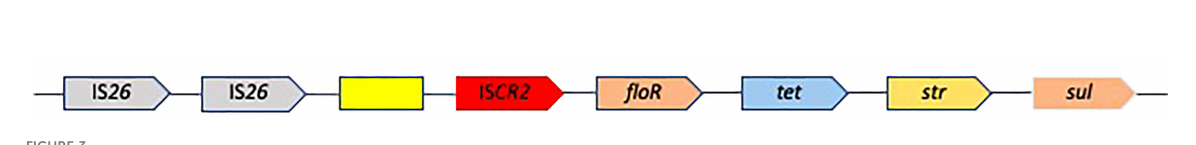
FIGURE 3 An IncA/C plasmid with de fi ned AMR gene cluster. The basic structure of the IncA/C plasmid carrying the fl oR-tetAR-strAB cluster is with three integration hotspots with two IS 26 , IS CR2 and an unknown ORF (yellow box) in between that facilitate the acquisition of additional genes.